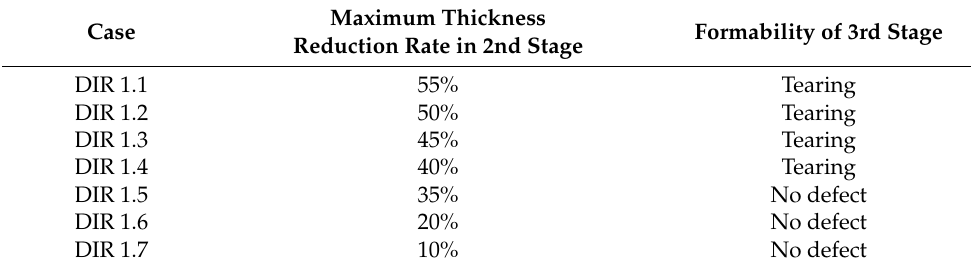
Table 4. Formability of 3rd stage according to the